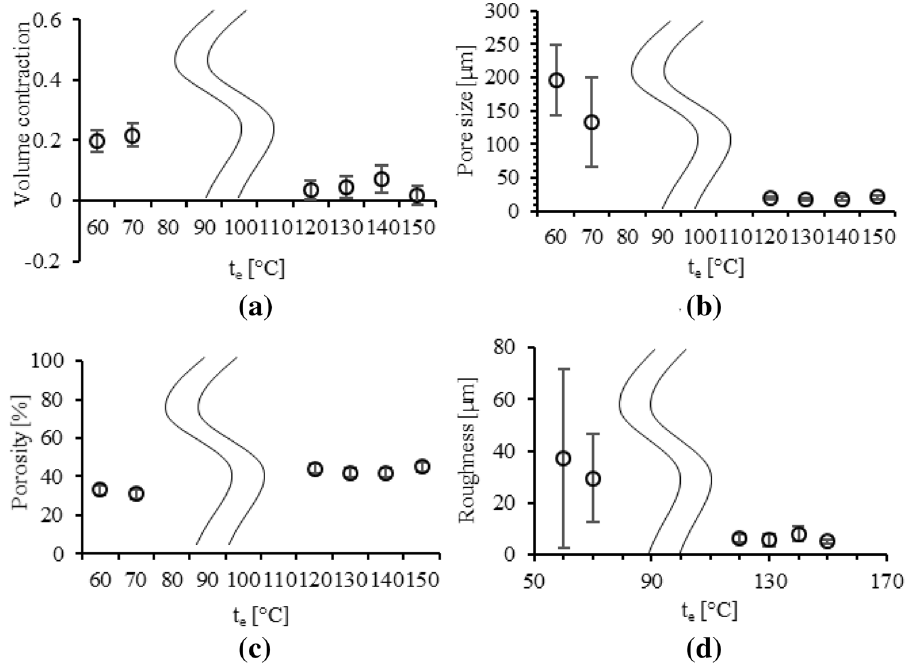
Figure 2. Properties of the present porous PDMS layer, fabricated at WMR = 0.5 for varying t e : ( a ) volumetric contraction; ( b ) pore size; ( c ) porosity; ( d ) surface